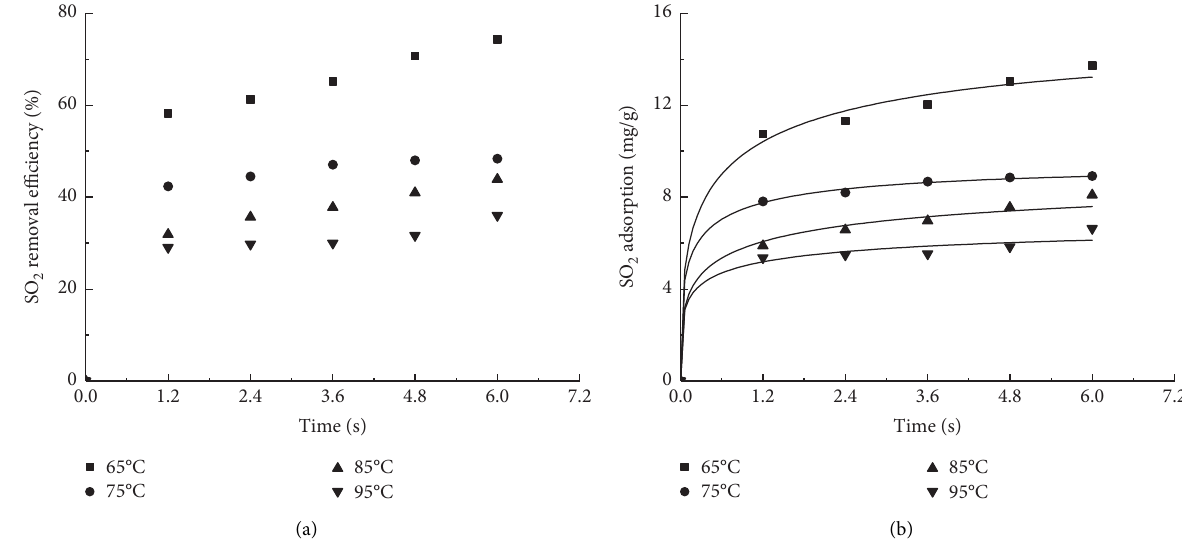
Figure 6: Influence of temperature on (a) SO